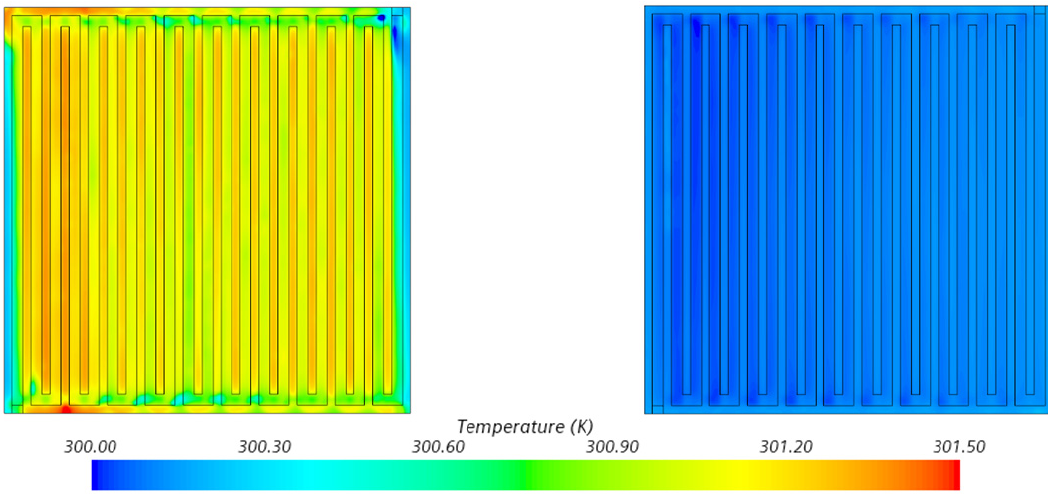
Figure 9. Section views of temperature at CCL for the 0.2 V ( left ) and the 0.7 V case ( right ).